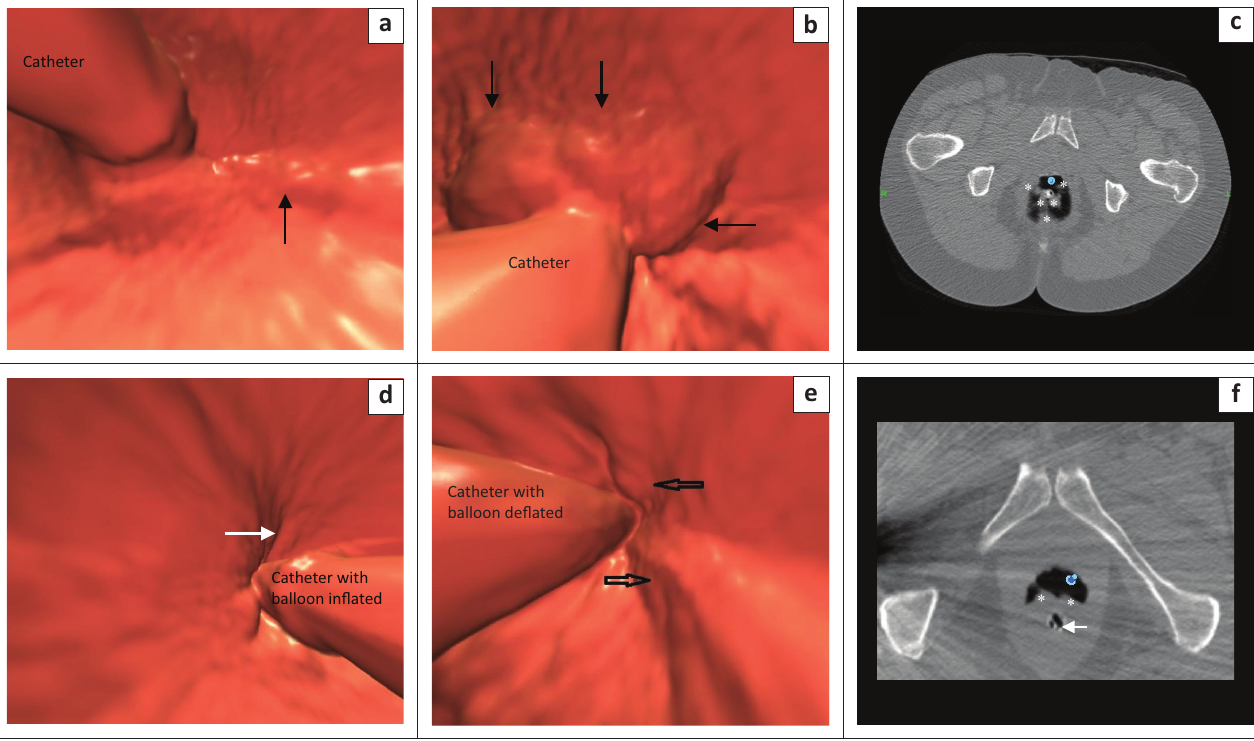
FIGURE 13: (a) Supine 3D view with inflated balloon showing internal haemorrhoid (black arrow); (b) Prone 3D view with deflated balloon showing polypoidal haemorrhoids (black arrows); (c) Prone 2D axial view with deflated balloon showing large haemorrhoids ( * ); (d) 3D supine view of inflated balloon. Internal haemorrhoid (white arrow); (e) 3D prone view with deflated balloon shows internal haemorrhoids more prominently (black arrows); (f) 2D axial view with deflated balloon (white arrow) showing internal haemorrhoids ( * ). White arrow indicates the placement of the